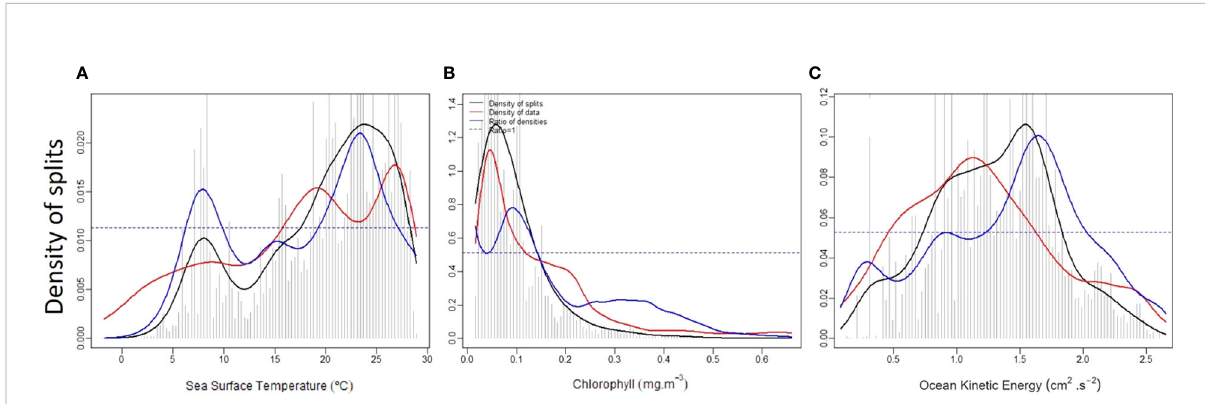
FIGURE 3 Binned split importance and location on each gradient (spikes), kernel density of splits (black lines), of observations (red lines), and splits standardized by observations density (blue lines) for the respective environmental parameters (A) . Sea Surface Temperature (SST, °C), (B) Chlorophyll- a (CHL, mg m -3 ), (C) Eddy Kinetic Energy (EKE, cm 2 s -2 )). These show where essential changes in the abundance of multiple species are occurring along a variable gradient, i.e., indicate a composition change